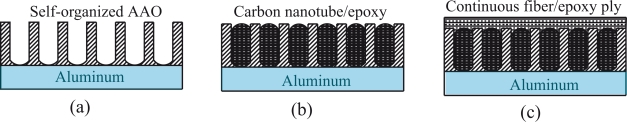
Schematic diagrams for nanoarchitecturing fiber reinforced epoxy/aluminum interface: (a) fabrication of AAO; (b) impregnation of active multi-wall carbon nanotubes/epoxy and adding nanoscaled spheres containing crack-healing resin and cure agent; (c) laminating continuous fiber reinforce epoxy plies and vacuum curing.